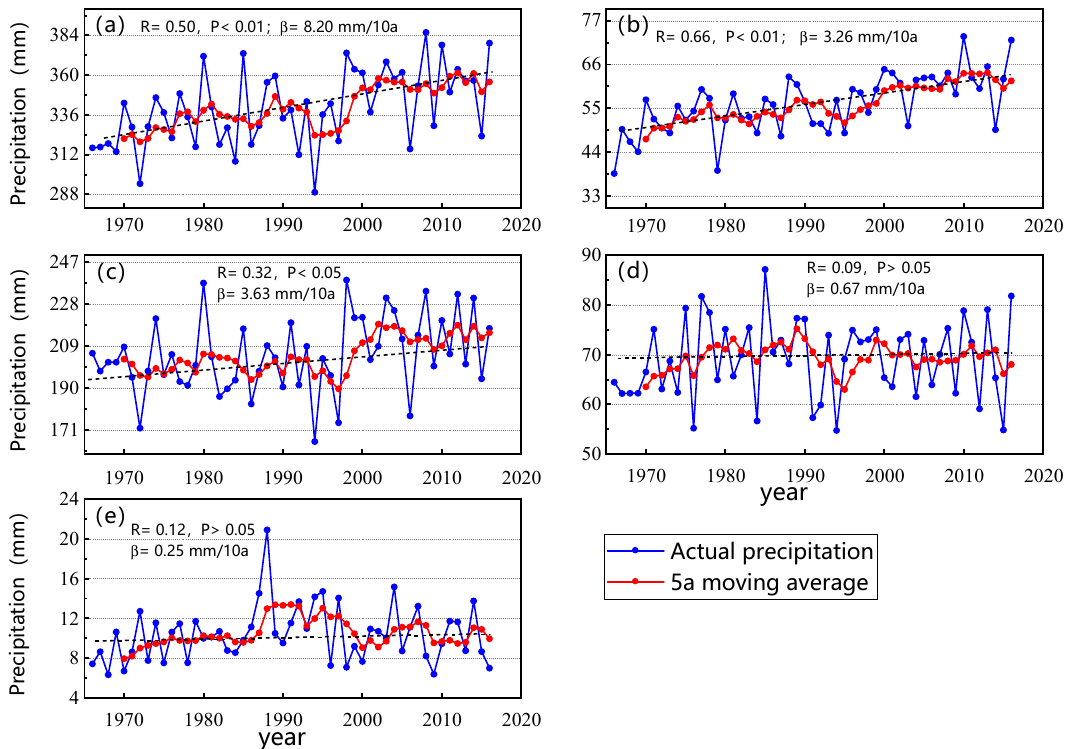
Figure 2. Variation of precipitation in the TP region on different timescales in 1966–2016. ( a ) Annual, ( b ) spring, ( c ) summer, ( d ) autumn, ( e ) winter.